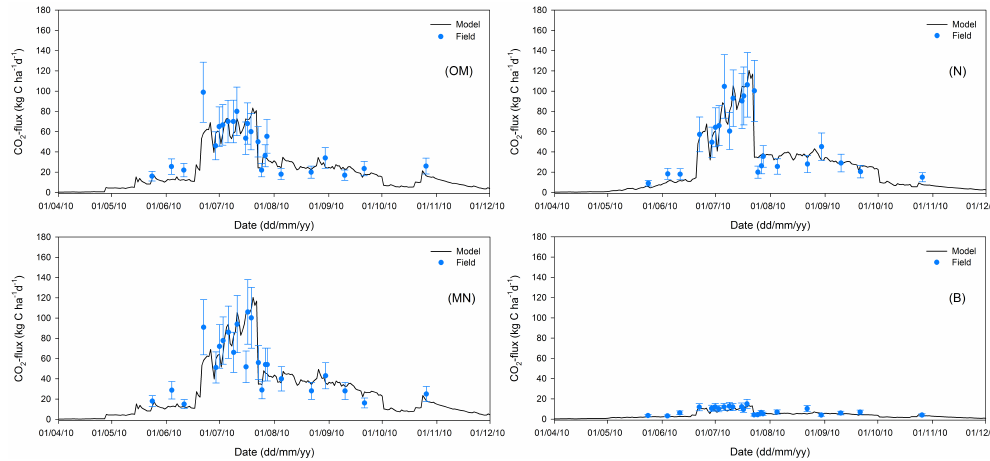
Fig. 4. Comparison of observed and modeled CO 2 emissions in summer maize